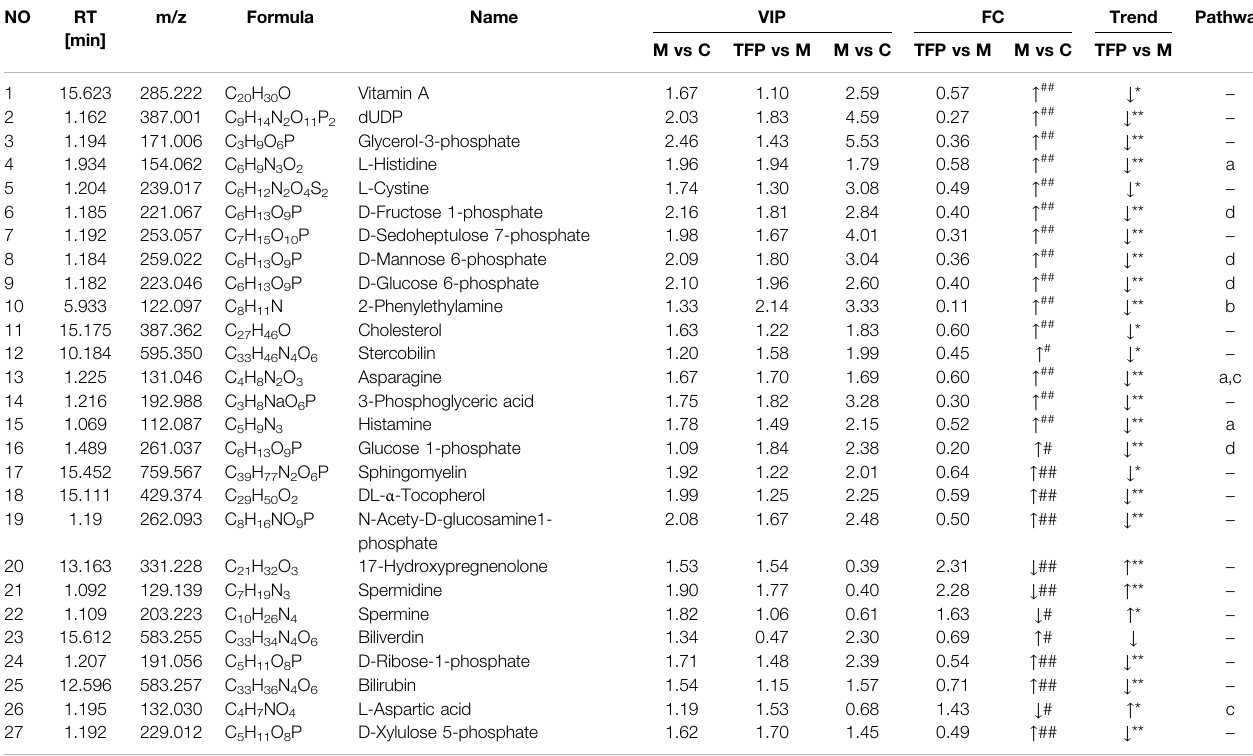
TABLE 2 | The differential metabolites in serum after TFP therapy. Formula